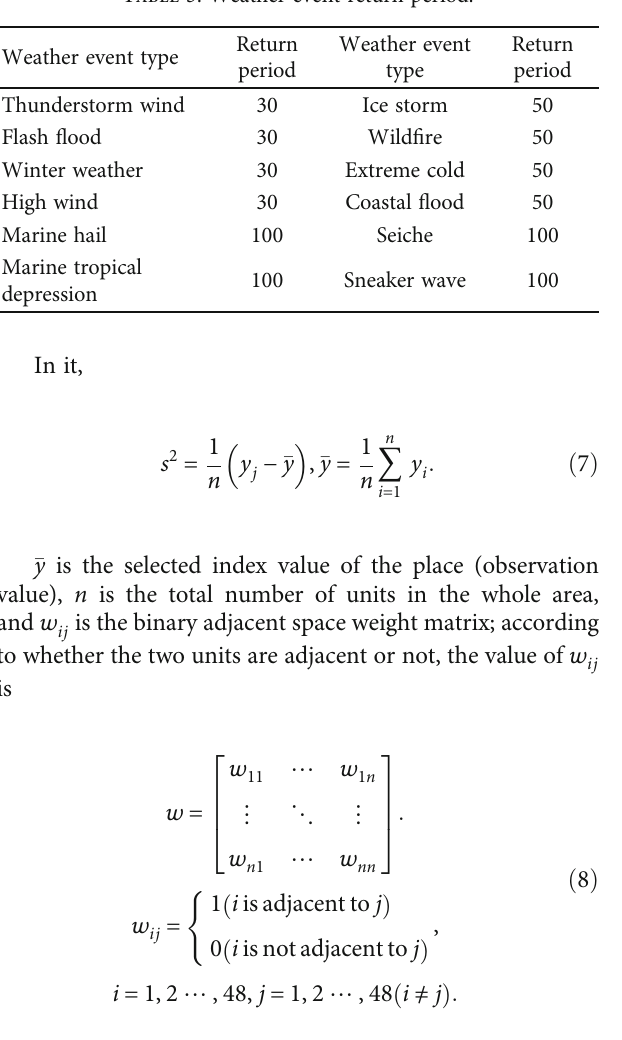
Table 3: Weather event return